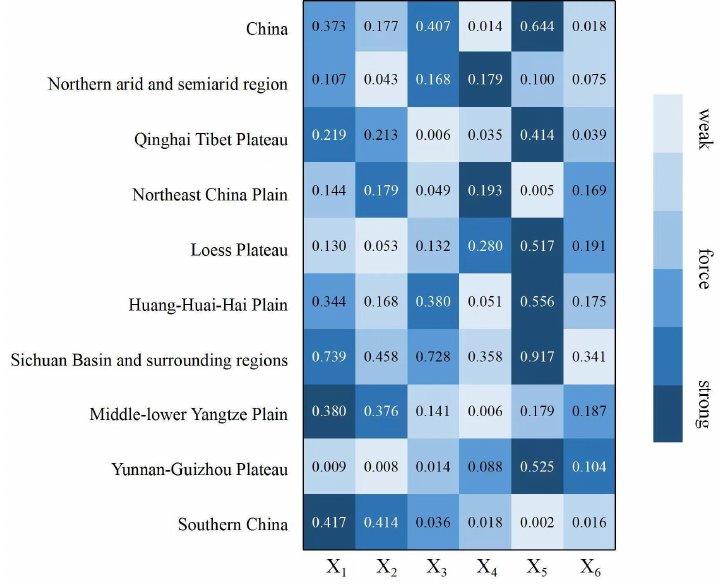
Figure 3. Comparison of the forces of detection factors in nine agricultural areas.